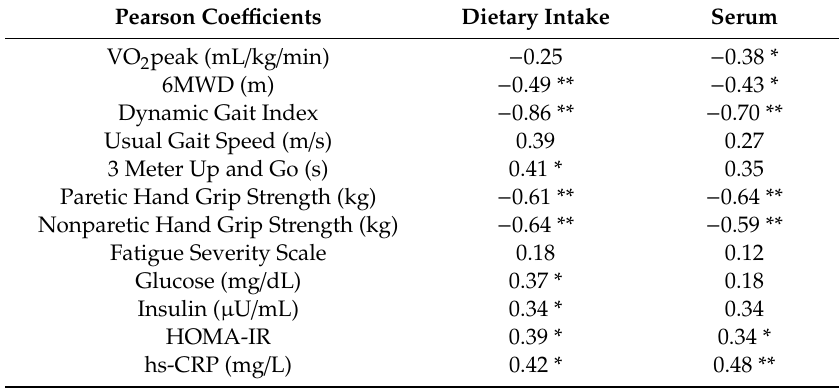
Table 3. Relationships between omega-6 / omega-3 dietary intake and serum concentrations and physical function and diabetes